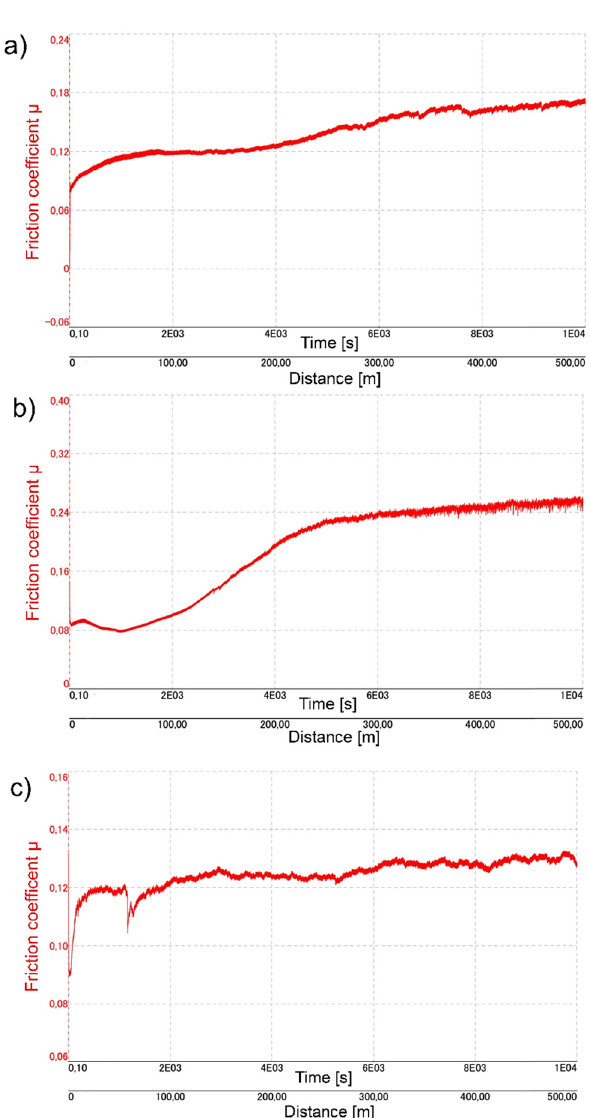
Figure 1: Charts of changes in coe ffi cient of friction recorded on a ball - on - disc stand at a distance of 500 m in technical dry friction conditions, respectively, for materials: ( a ) iglidur A180, ( b ) iglidur X, and ( c ) iglidur P210. Figure 2: A graph of the values of wear coe ffi cients K